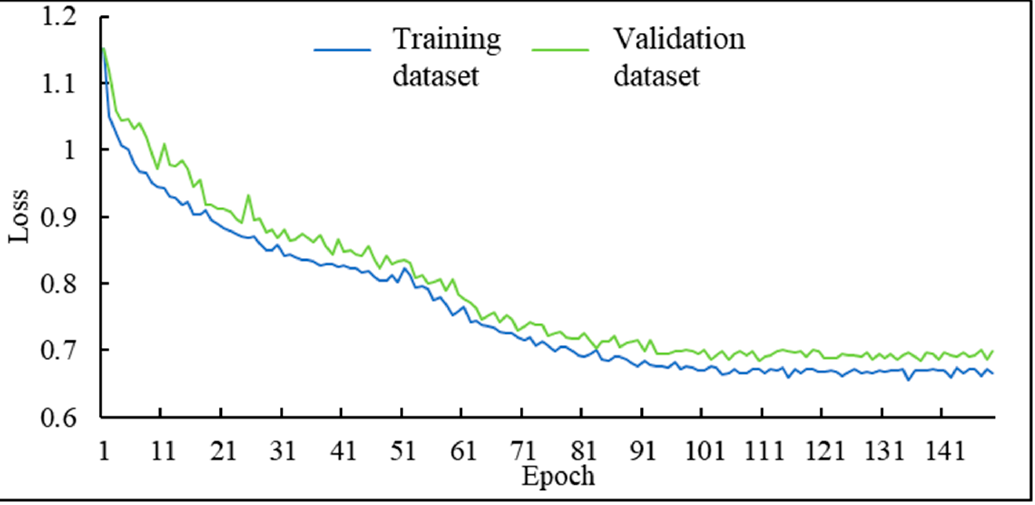
Figure 9. Loss curves during model training.